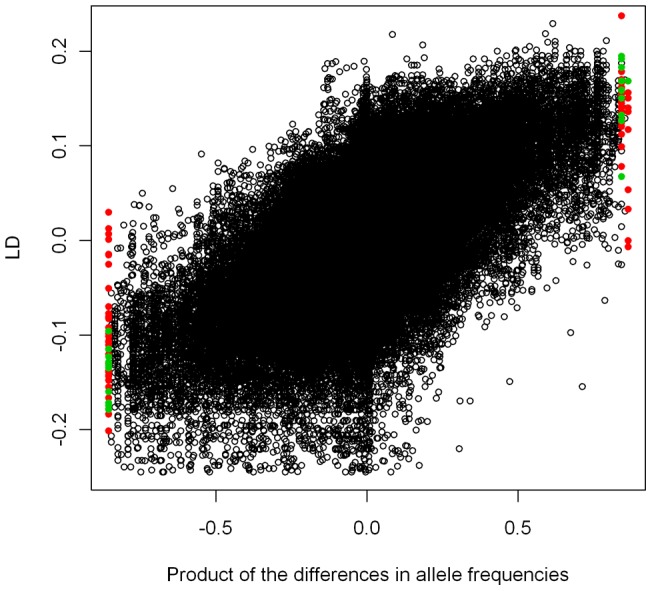
Linkage disequilibrium between outlier locus pairs versus neutral locus pairs in hybrid individuals.The product of differences in allele frequencies [(p–q)*(r–s)] between parental populations for all pair-wise combinations of loci between P24(XY)-east and viatica17-east, versus linkage disequilibrium (LD) between the same locus pairs in hybrid individuals. Black open circles: non-outlier locus pairs, red filled circles: pairs of outlier loci identified only in the viatica17-east and P24(XY)-east comparison, green filled circles: pairs of outlier loci identified both in the viatica17-east and P24(XY)-east comparison and the viatica17-south and P24(XY)-north comparison. Outlier points with positive x-axis values comprise outlier locus pairs, of which both were fixed for the presence allele in the same population. Outlier points with negative x-axis values comprise outlier locus pairs which were fixed for the presence allele in opposite populations.